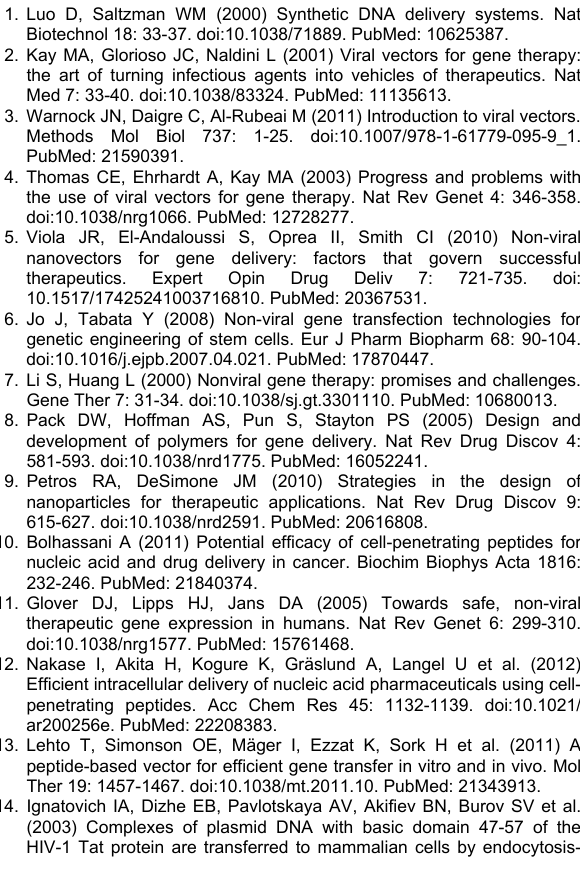
Figure S3. Intracellular final fate of DNA/peptide complex in HeLa cells. Colocalization of Lysosensor signal (lysosome marker, green) with atto633-CM Figure S1. CM -Tat /DNA in vitro transfection efficiency 18 11 signal (red) after 12 h of treatment. The overlay (yellow) in CHO cells. Transgene expression is detected 24 hours reveals that the complex is completely delivered to the after transfection by measuring luciferase activity from an lysosomal aliquot of the CHO cells external medium. Light grey column is the mean value obtained with naked DNA, dark grey column is for lipofectamine, while red column is for CM -Tat /DNA 18 11 complex at N:P ratio 16:1. The reported RLU/well values represent the mean of three independent measurements, each performed in triplicate.